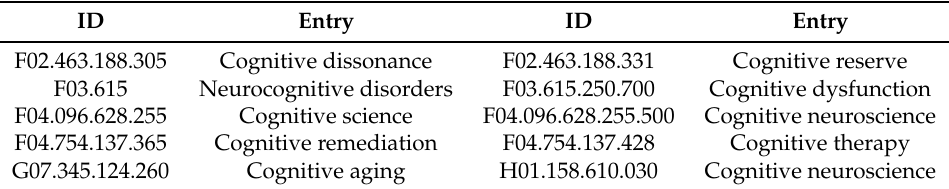
Table 4. Cognitive-related MeSH